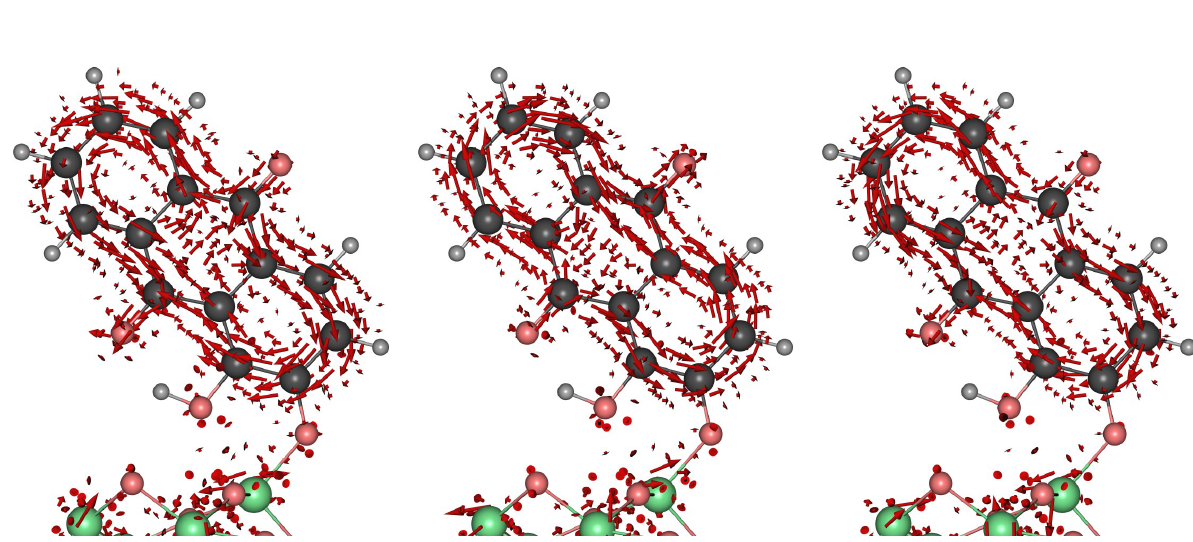
Figure 7. Electronic flux density j ( r , t ) at t = 0 . 70 fs ( left ), t = 2 . 15 fs ( center ), and t = 3 . 40 fs ( right ). The red arrows describe the instantaneous flow of electronic density. The snapshots were chosen at the turning points in the dynamics, where the electronic density is symmetrically distributed on the molecule (see Figure 6). Electrons are seen to flow from one carbonyl to the other via the aromatic rings. At the t = 2 . 15 fs, the flow direction is